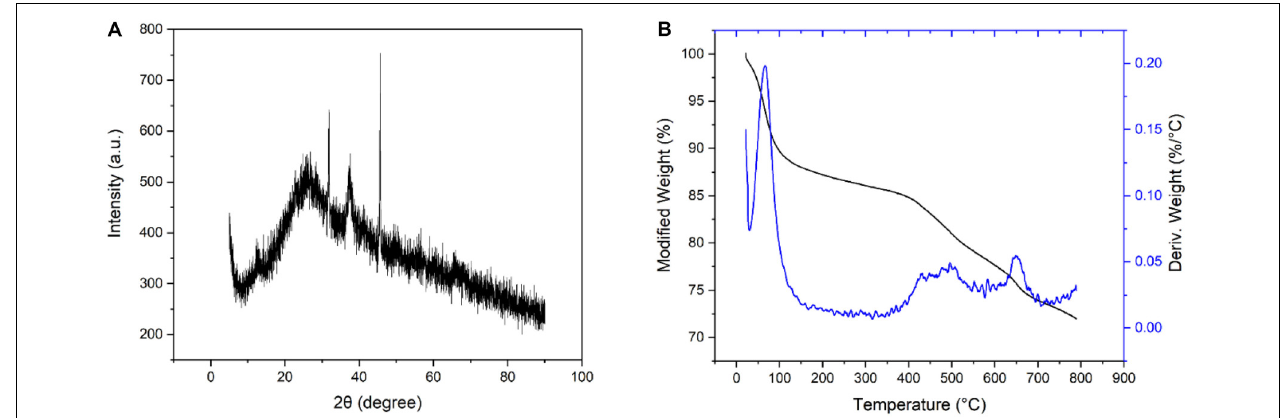
FIGURE 4 | (A) XRD spectrum of BC/MnO 2 , (B) TG curves of BC/MnO 2 .